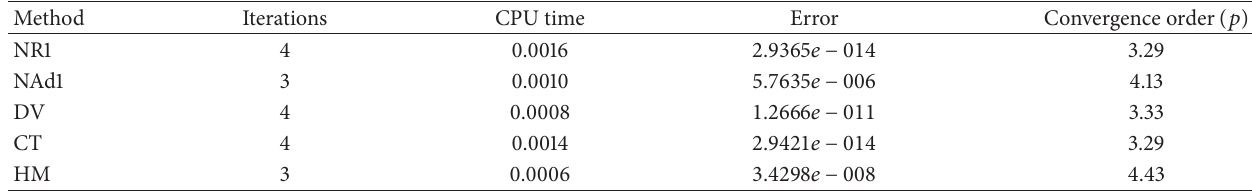
Table 5: Numerical results of Example 4 with initial value 𝑥 0 = (1,1, 1, −2) 𝑇 .